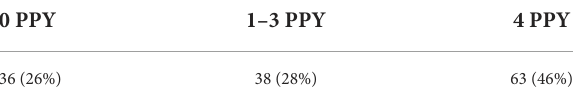
TABLE 1 Distribution of participants by prior programming